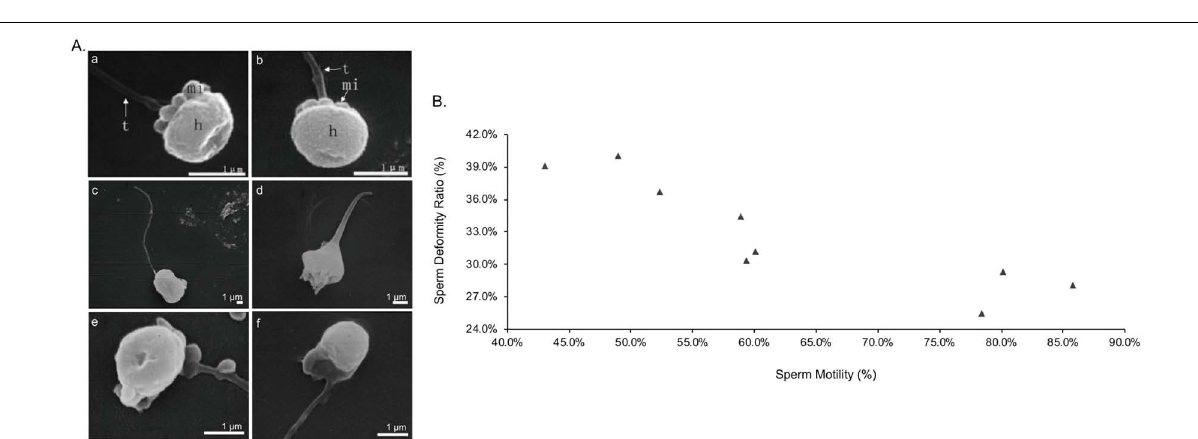
content at the stages of II(70 g) and VI(2500 g) ( Figure 6Bf